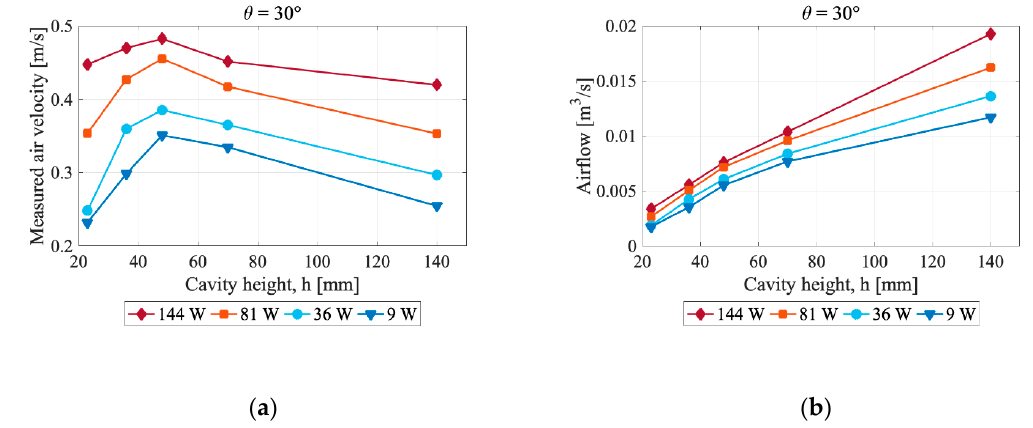
Figure 8. ( a ) Measured air velocity in relation to the air cavity height at a roof inclination of 30°; ( b ) Calculated airflow rate presented in relation to the air cavity height at a roof inclination of 30°.